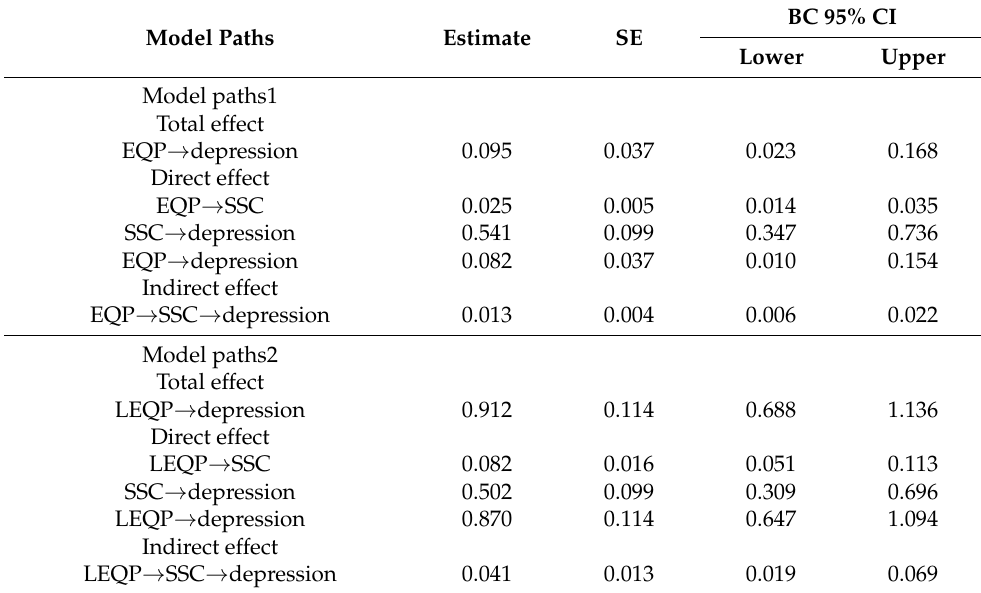
Table 4. Non-standardized mediation analysis